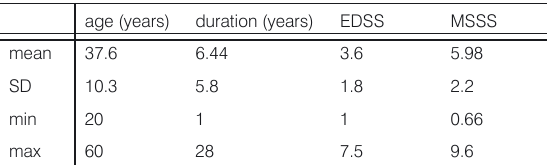
Table 1. Clinical characteristics of the study